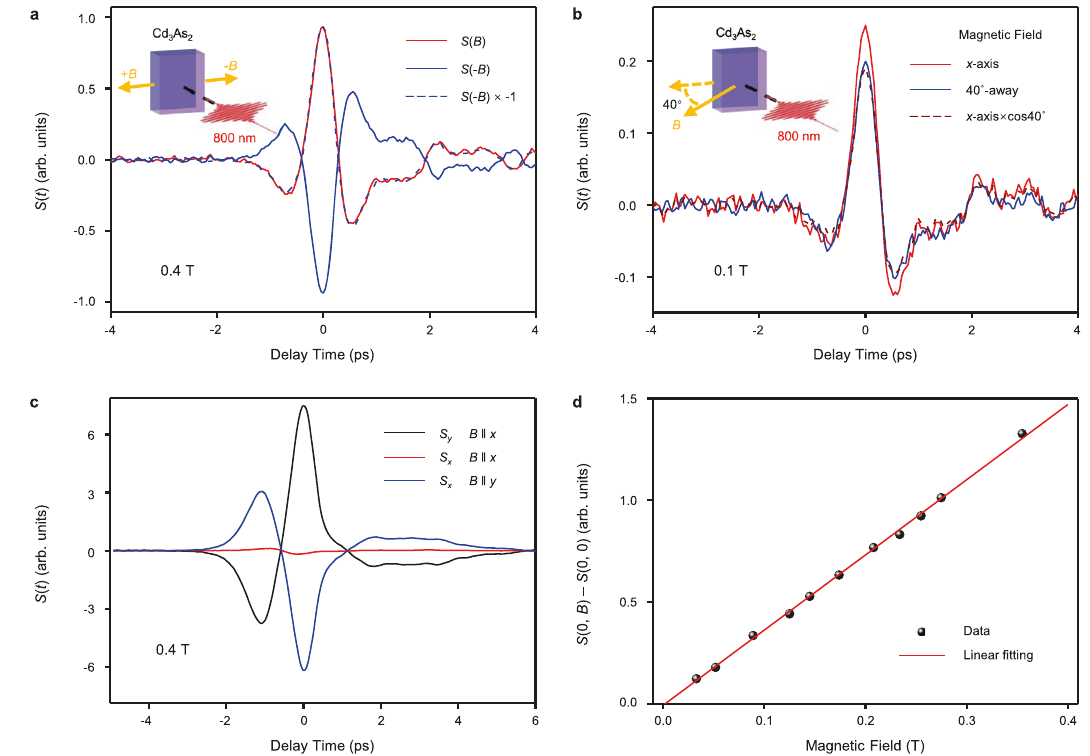
Fig. 4 Magnetic fi eld dependences of THz emission. a The THz emissions at reverse magnetic fi elds of 0.4 T. The dash line is the reversion of waveform at B = ‒ 0.4 T. b The THz emissions when a 0.1 T-magnetic fi eld is applied at x -axis and 40 ° away from x -axis in xz -plane, respectively. The dash line is the THz waveform under x -directional magnetic fi eld multiplying by cos40 ° . c The x - and y -polarization components of the THz emissions with magnetic fi eld B ‖ x and B ‖ y . d The amplitude of net magnetic THz signal at time zero as a function of the intensity of magnetic fi eld. Insets in panels ( a , b ): the schematic illustrations of the corresponding